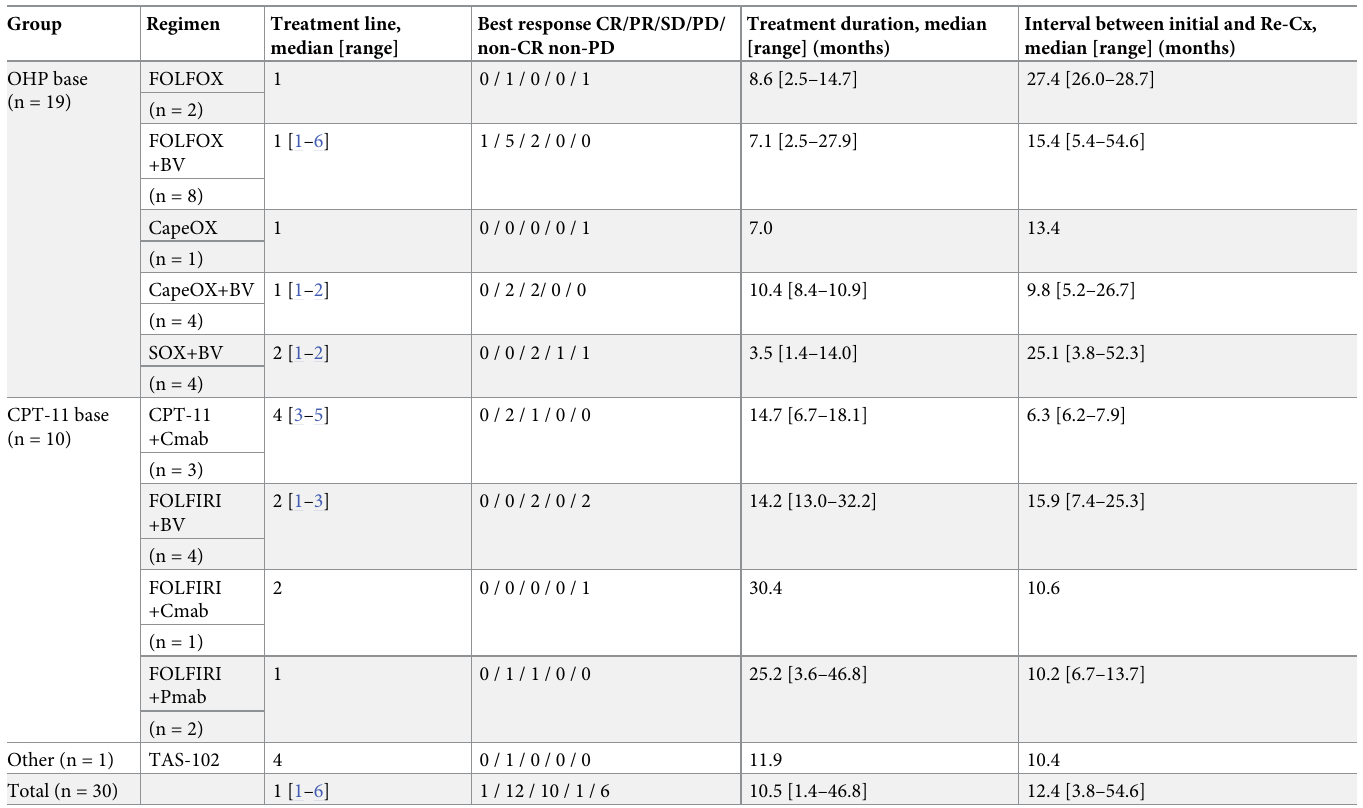
Table 2. Initial Re-Cx (30